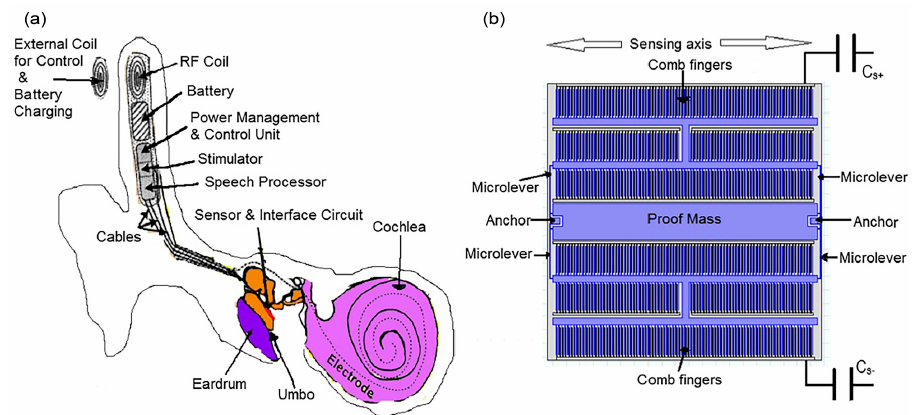
Figure 21. ( a ) The proposed fully implantable microphone at umbo in the middle ear. ( b ) The 2D layout of the accelerometer with differential capacitances. The capacitive sensed-fingers are connected to the proof mass through a system of microlevers [82]. Reprinted by permission from Springer Nature Customer Service Centre GmbH: Springer Nature MI- CROSYSTEM TECHNOLOGIES Numerical simulation and modelling of a novel MEMS capacitive accelerometer based microphone for fully implantable hearing aid, A. Dwivedi et al., COPYRIGHT (2019).